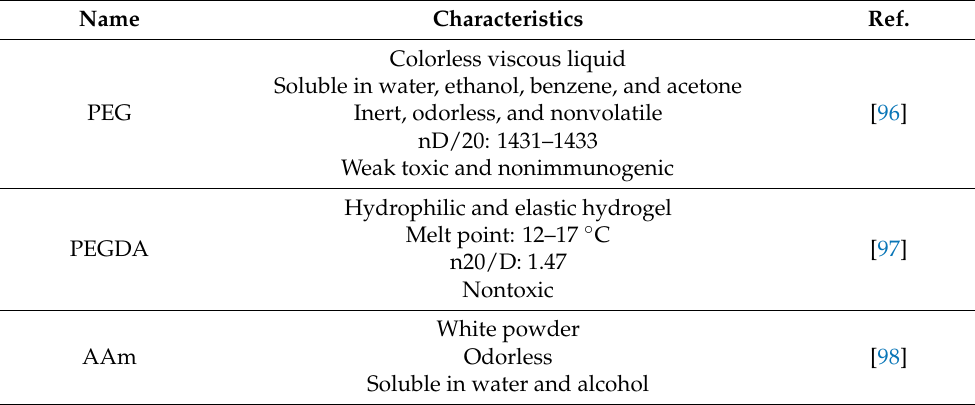
Table 2. Main characteristics of the hydrogel materials.